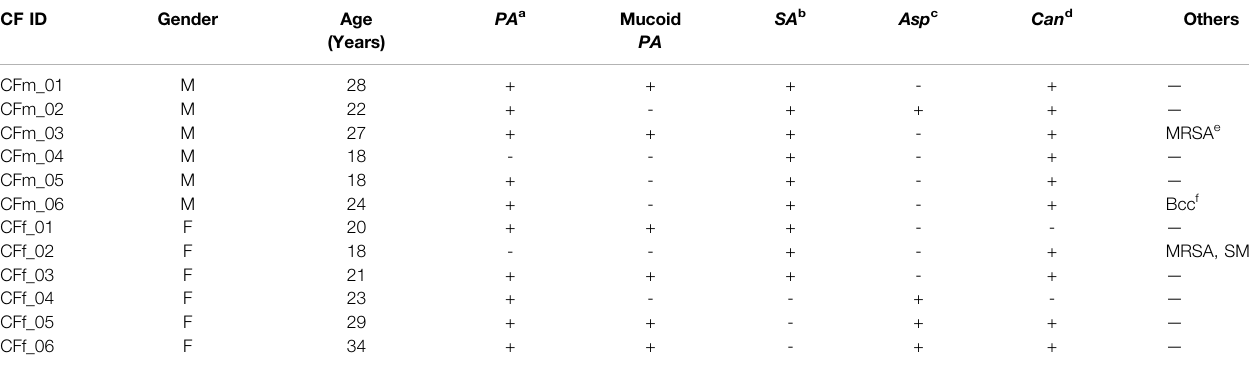
TABLE 1 | Demographics and colonisation status of the CF cohort.